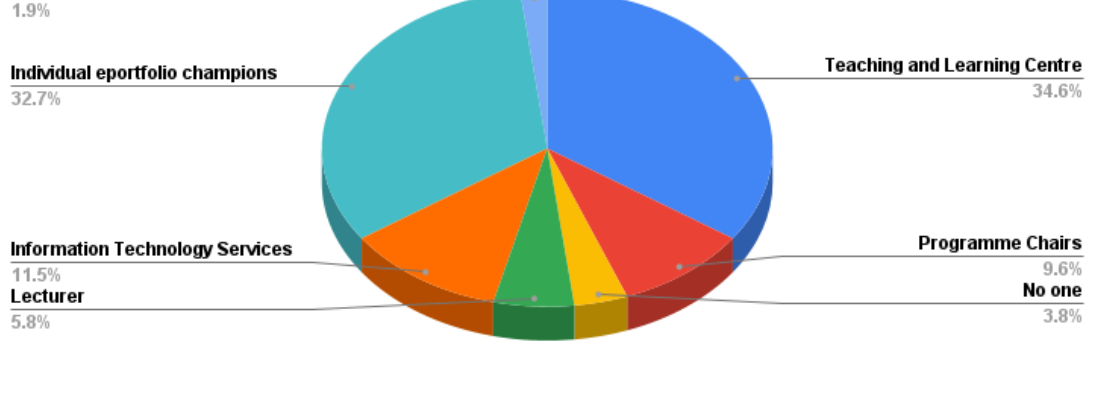
Pace of institutional eportfolio adoption